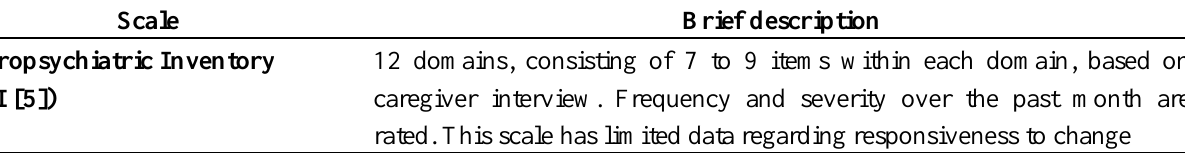
Table 2. Brief description of global behavioral assessment